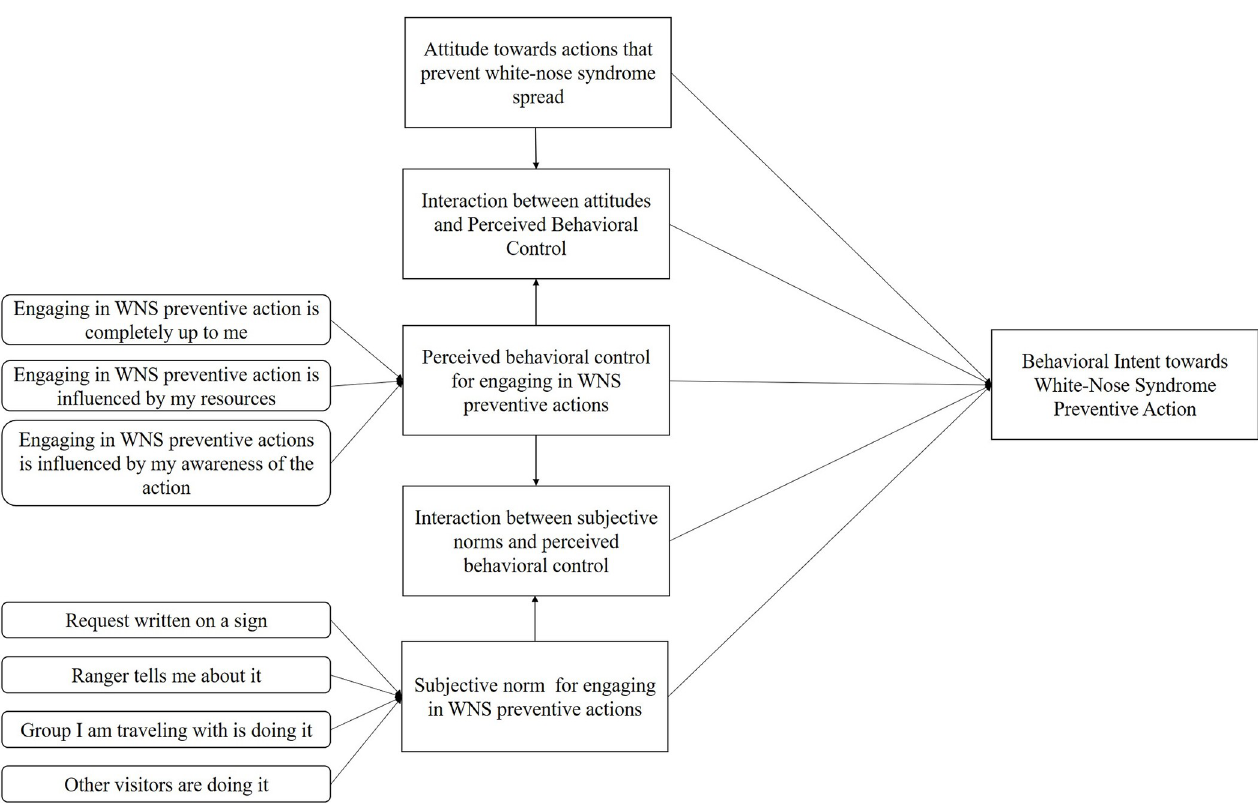
Fig 2. Example of the theory of planned behavior template used for each of the five white-nose syndrome preventive strategies used in U.S. national parks.